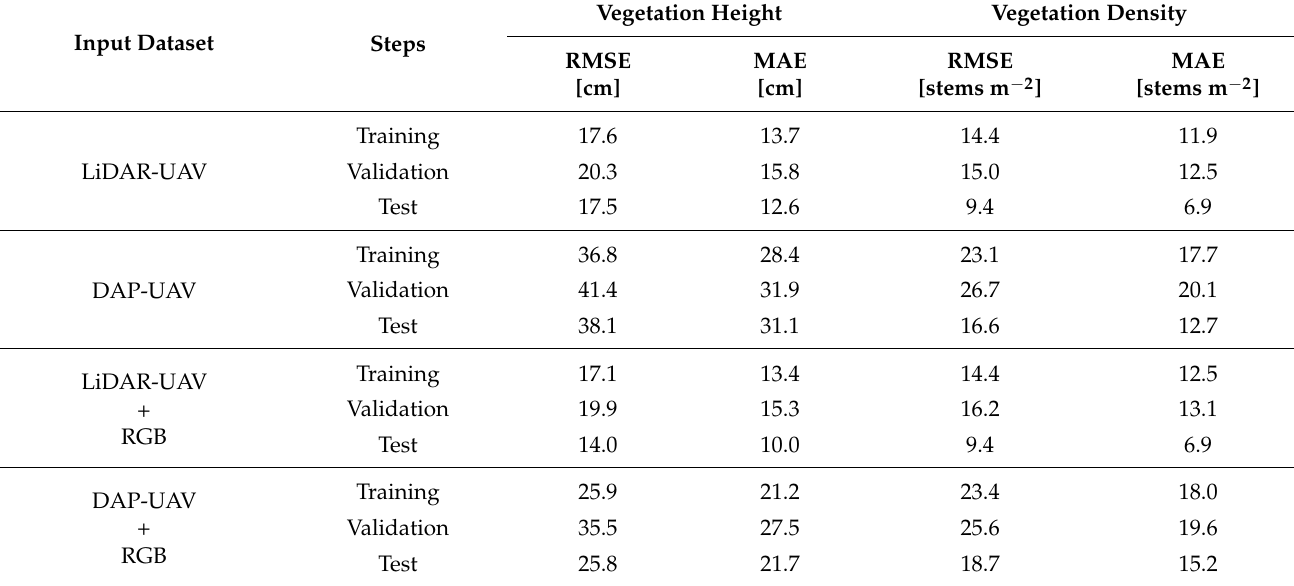
Table 4. Evaluation metrics (reported in centimeters for the vegetation height, and in stems m − 2 for the vegetation density) we obtained for the estimated vegetation height. The metrics are reported for all the steps of the validation procedure applied to the genetic algorithm and are rounded at the first decimal unit. The errors are reported for the LiDAR-UAV, Digital Aerial Photogrammetry (DAP)-UAV, LiDAR-UAV plus RGB, and DAP-UAV plus RGB predictors. The list of the predictors obtained from each dataset is reported in Table